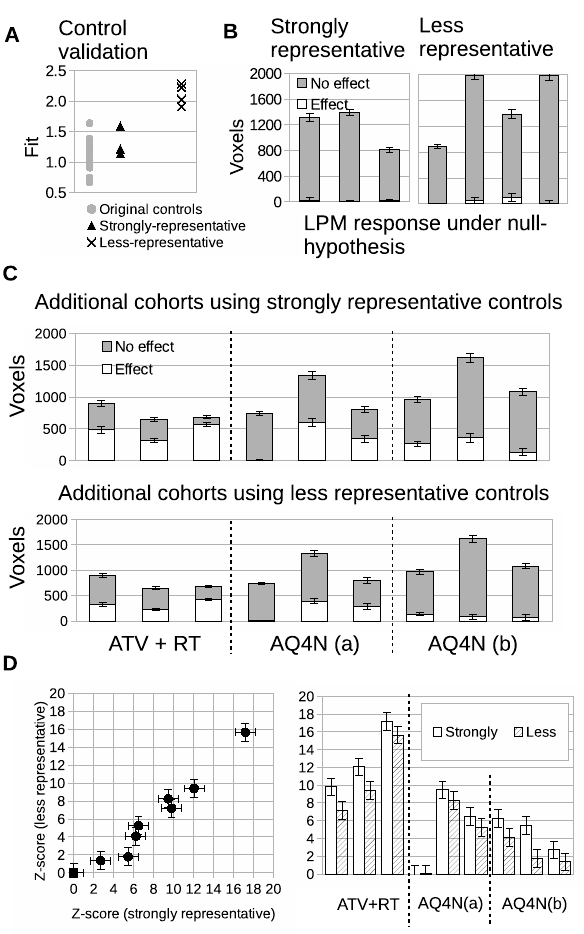
Figure 10. Validation and conformity checking of additional control tumors. ( A ) LPM goodness-of- fit ( χ 2 per d.f.) of additional control distributions compared against original controls (grey discs). The ‘strongly representative’ controls are the triangular points and the ‘less representative’ controls are the crosses. ( B ) Validation that when re-trained using additional controls, the LPM models show that both groups are consistent with there being no treatment effects. LPM analysis of additional treatment cohorts. ( C ) Volumetric assessment of tumor changes in response to the additional treatments with different control models (ATV with RT, AQ4N(a) with single dose of 60 mg/kg, AQ4N(b) 3 doses of 20 mg/kg daily). ( D ) Statistical significance, in terms of Z-scores, of treatment effects compared across both control groups